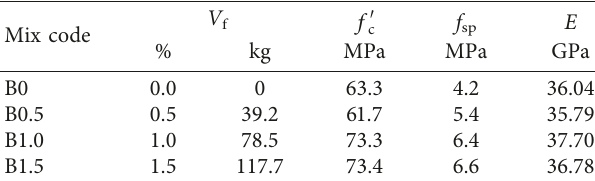
Figure 3: Sectional geometry and reinforcing details of the solid and hollow beams. Table 2: Fiber volume fraction and control test results of the four